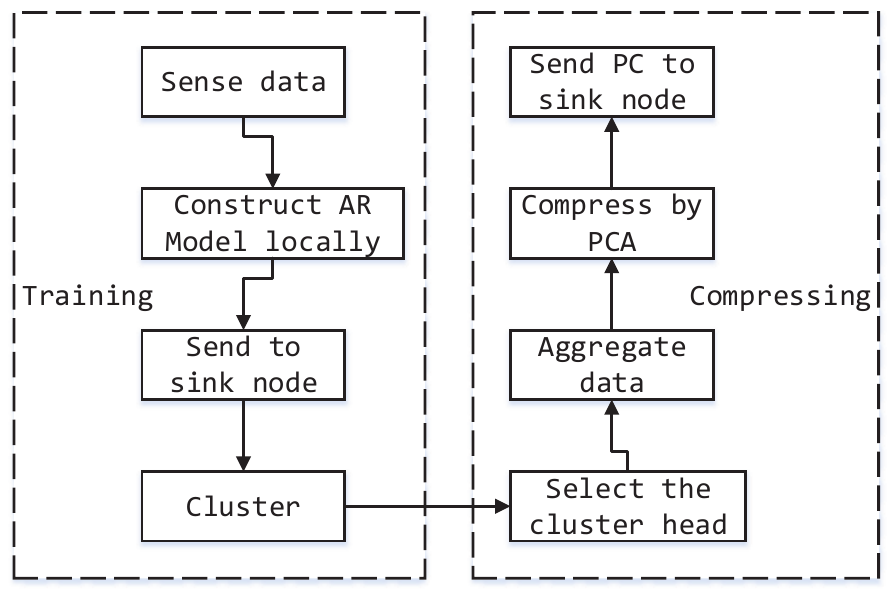
Figure 4. Execution procedure of our